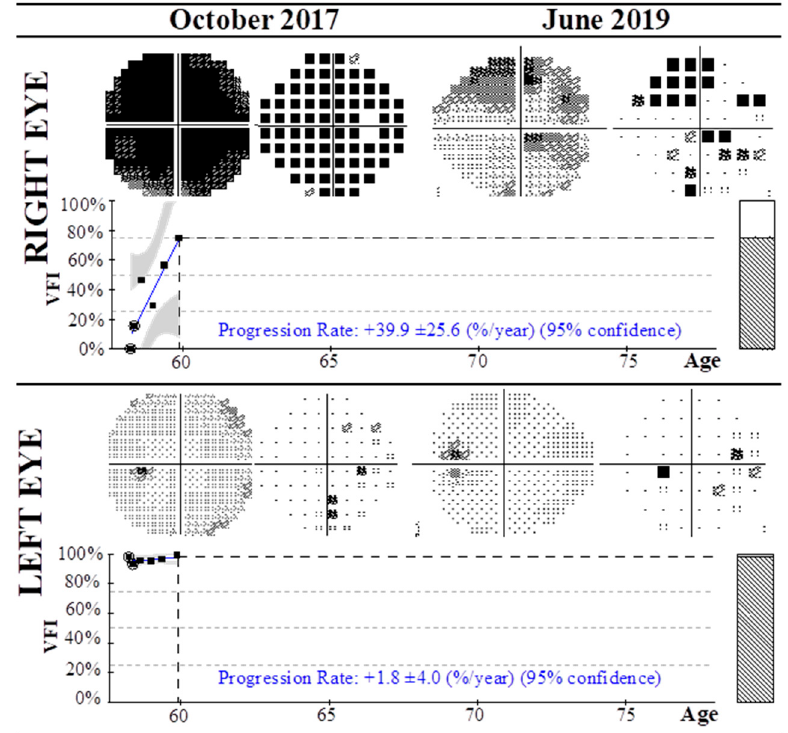
Figure 3. Summary of visual field test with Humphrey field analyzer and 30-2 algorithm of a patient diagnosed with CRAO affecting the right eye (RAO01) from October 2017 to June 2019. From 2017 to date the patient was treated with CoQ10 and vitamins, with progressive improvement of the visual field index in both eyes. Progression rates at 95% confidence level are shown.